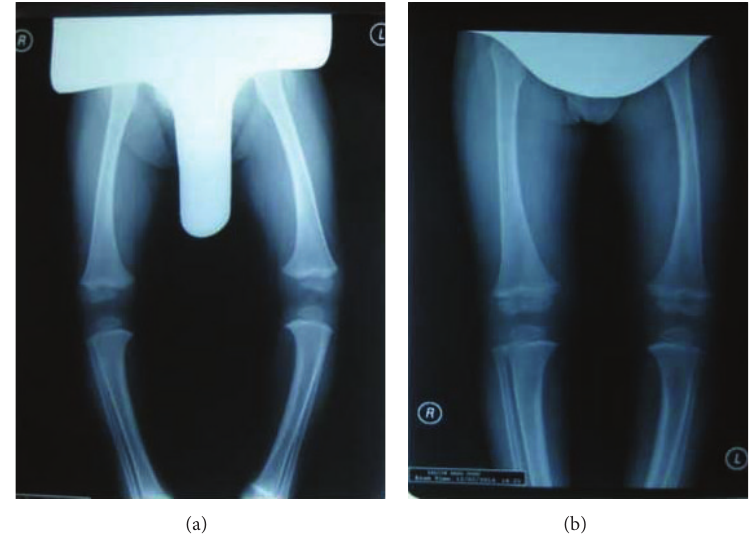
Figure 2: Anteroposterior radiographs of lower extremity: (a) pretreatment, (b)